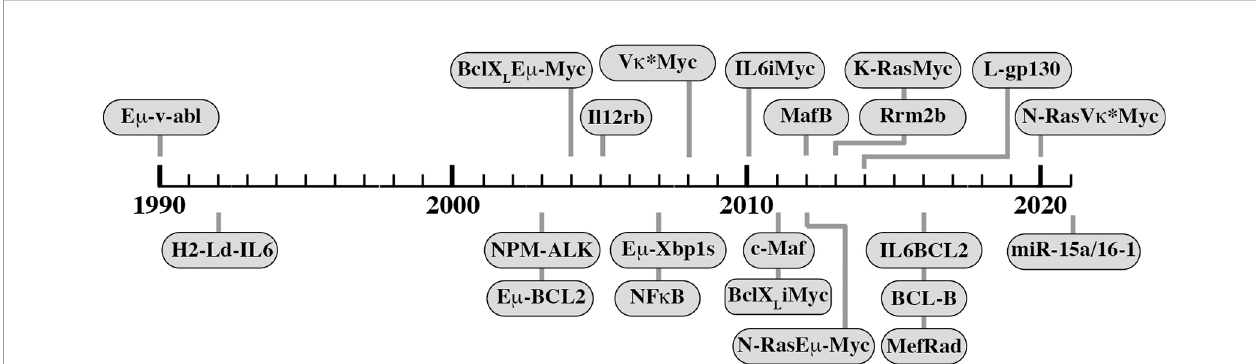
FIGURE 5 | Transgenic mouse models of human plasma cell myeloma and extramedullary plasmacytoma. Shown is a timeline of model development that begins with Eµ-v-abl developed by Susan Cory ’ s group at WEHI and published in 1990. The H2-L d -IL6 model of human plasmacytoma published in 2002 gave rise to the double-transgenic MycIL6 and BCL2IL6 models that take advantage of oncogene collaboration to accelerate neoplastic plasma cell development. Similarly, V k *MYC, the premier model of myeloma immunology research, was recently accelerated by breeding in a mutated Ras gene, leading to the highly promising VQ model published in